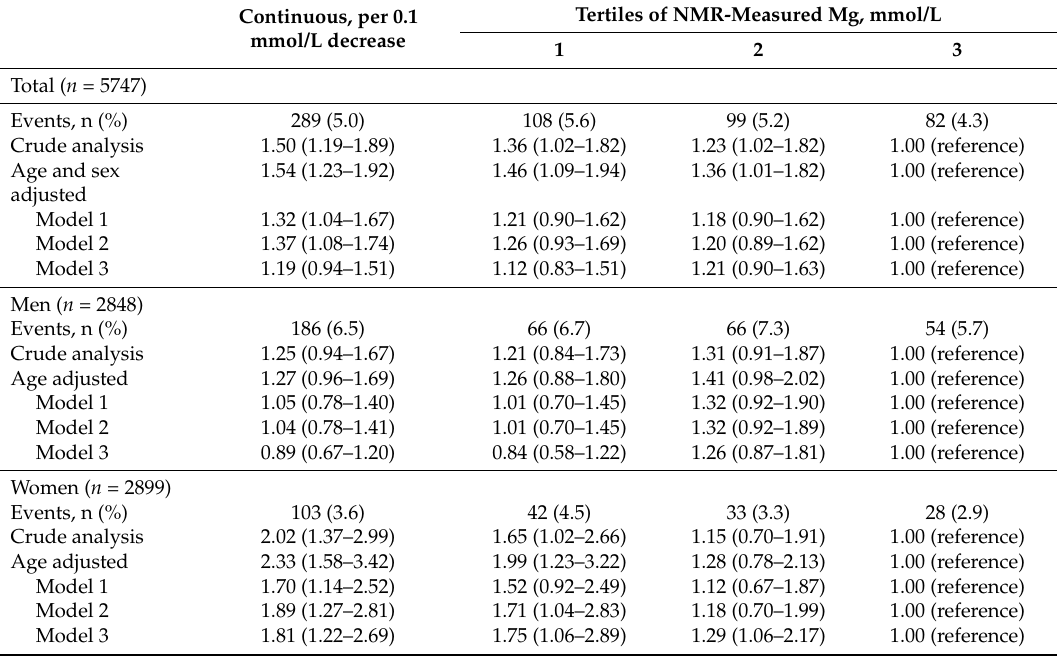
Table 4. The association of NMR-measured ionized Mg with the risk of developing T2DM in the PREVEND study (sensitivity